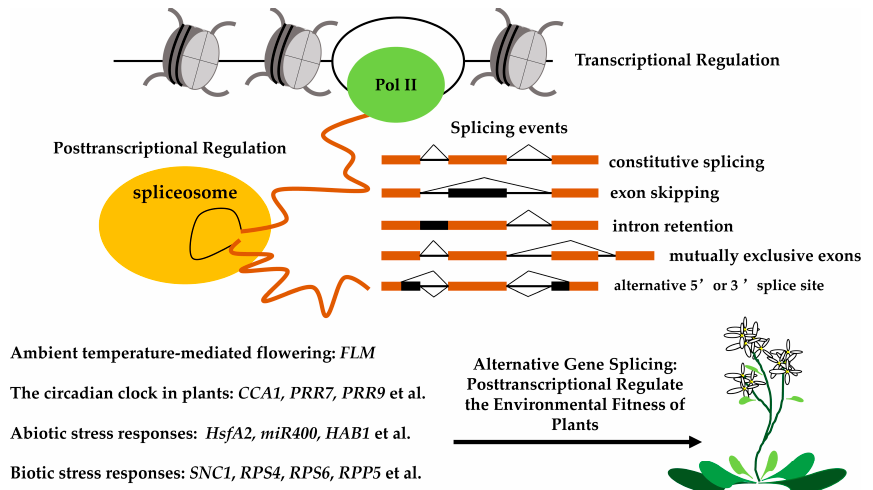
Figure 5. Alternative gene splicing is a novel means of regulating the environmental fitness of plants. Processing of pre-mRNA splicing is initiated during transcription. Splicing is performed by the spliceosome, a large ribonucleoprotein (RNP) complex that assembles around splice sites in the introns of a pre-mRNA molecule and then removes the introns catalytically through sequential phosphodiester transfer reactions. One pre-mRNA generate different mRNA isoforms via alternative splicing events, such as usage of an alternative 3 (cid:48) or 5 (cid:48) splicing site, exon skipping, intron retention, and mutually exclusive exons. Given their sessile nature, plants must adapt immediately to environmental changes of plants through alternative gene